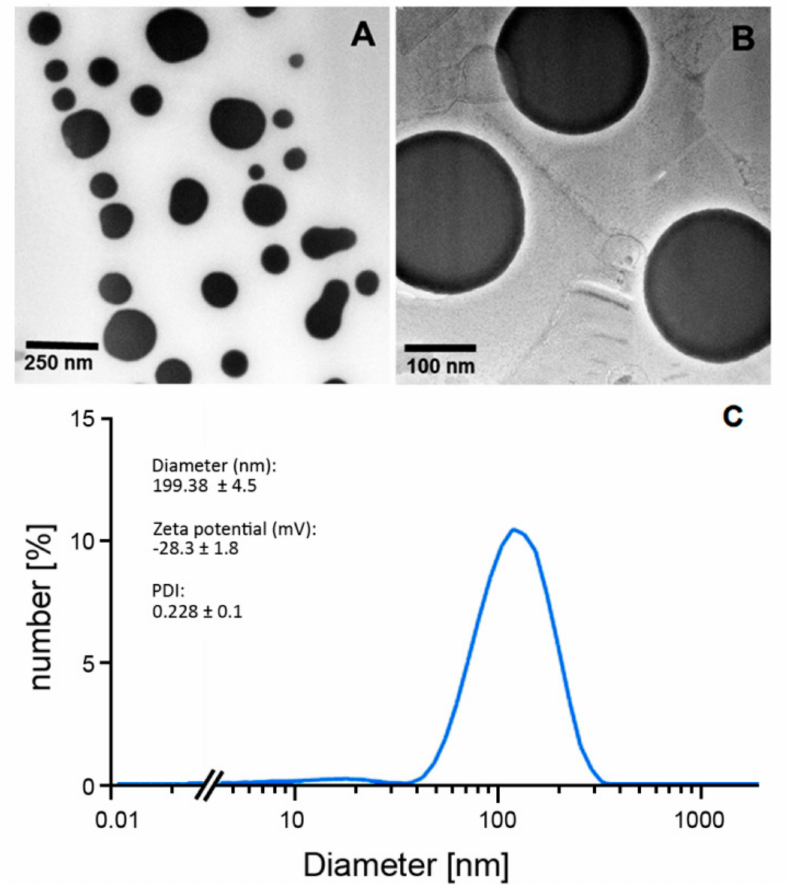
Figure 1. Physicochemical characteristics of curcumin liposomes. Transmission electron microscopical images depicting the morphology and size variance of curcumin liposomes ( A , B ) were generated as previously described by Duse et al. [29]. Shown are characteristic features of the used curcumin liposomes such as diameter (size) distribution, zeta potential, and polydispersity index (PDI) ( C ). ” // ” in the x-axis shortens the logarithmic scale in the non-relevant lower range for better presentability of the actual size range of curcumin